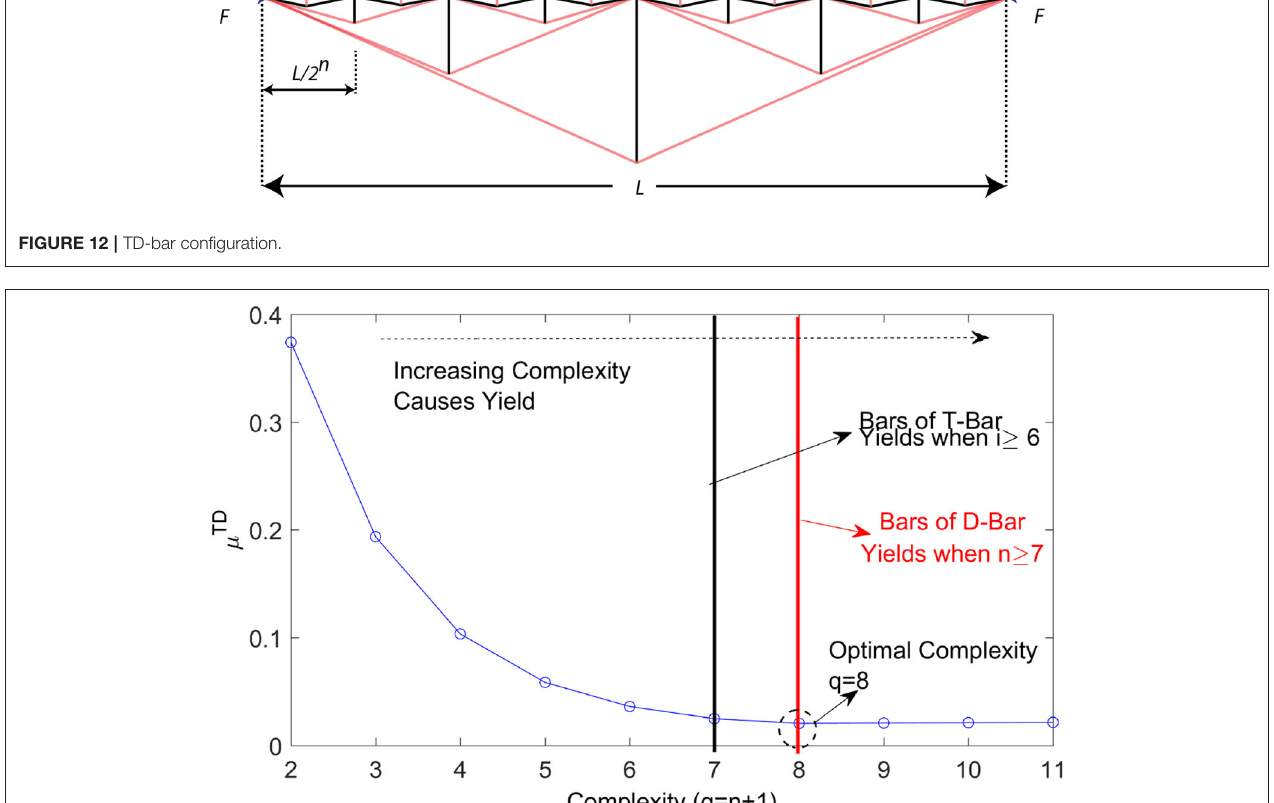
FIGURE 13 | Mass ratio of the configuration vs. the complexity of the